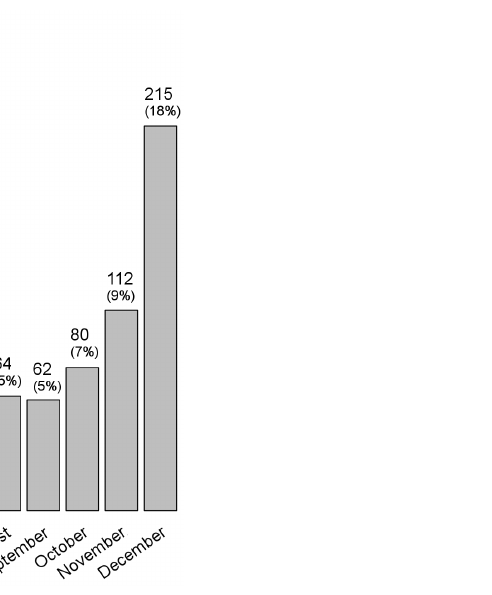
doi:10.1371/journal.pone.0115124.g003